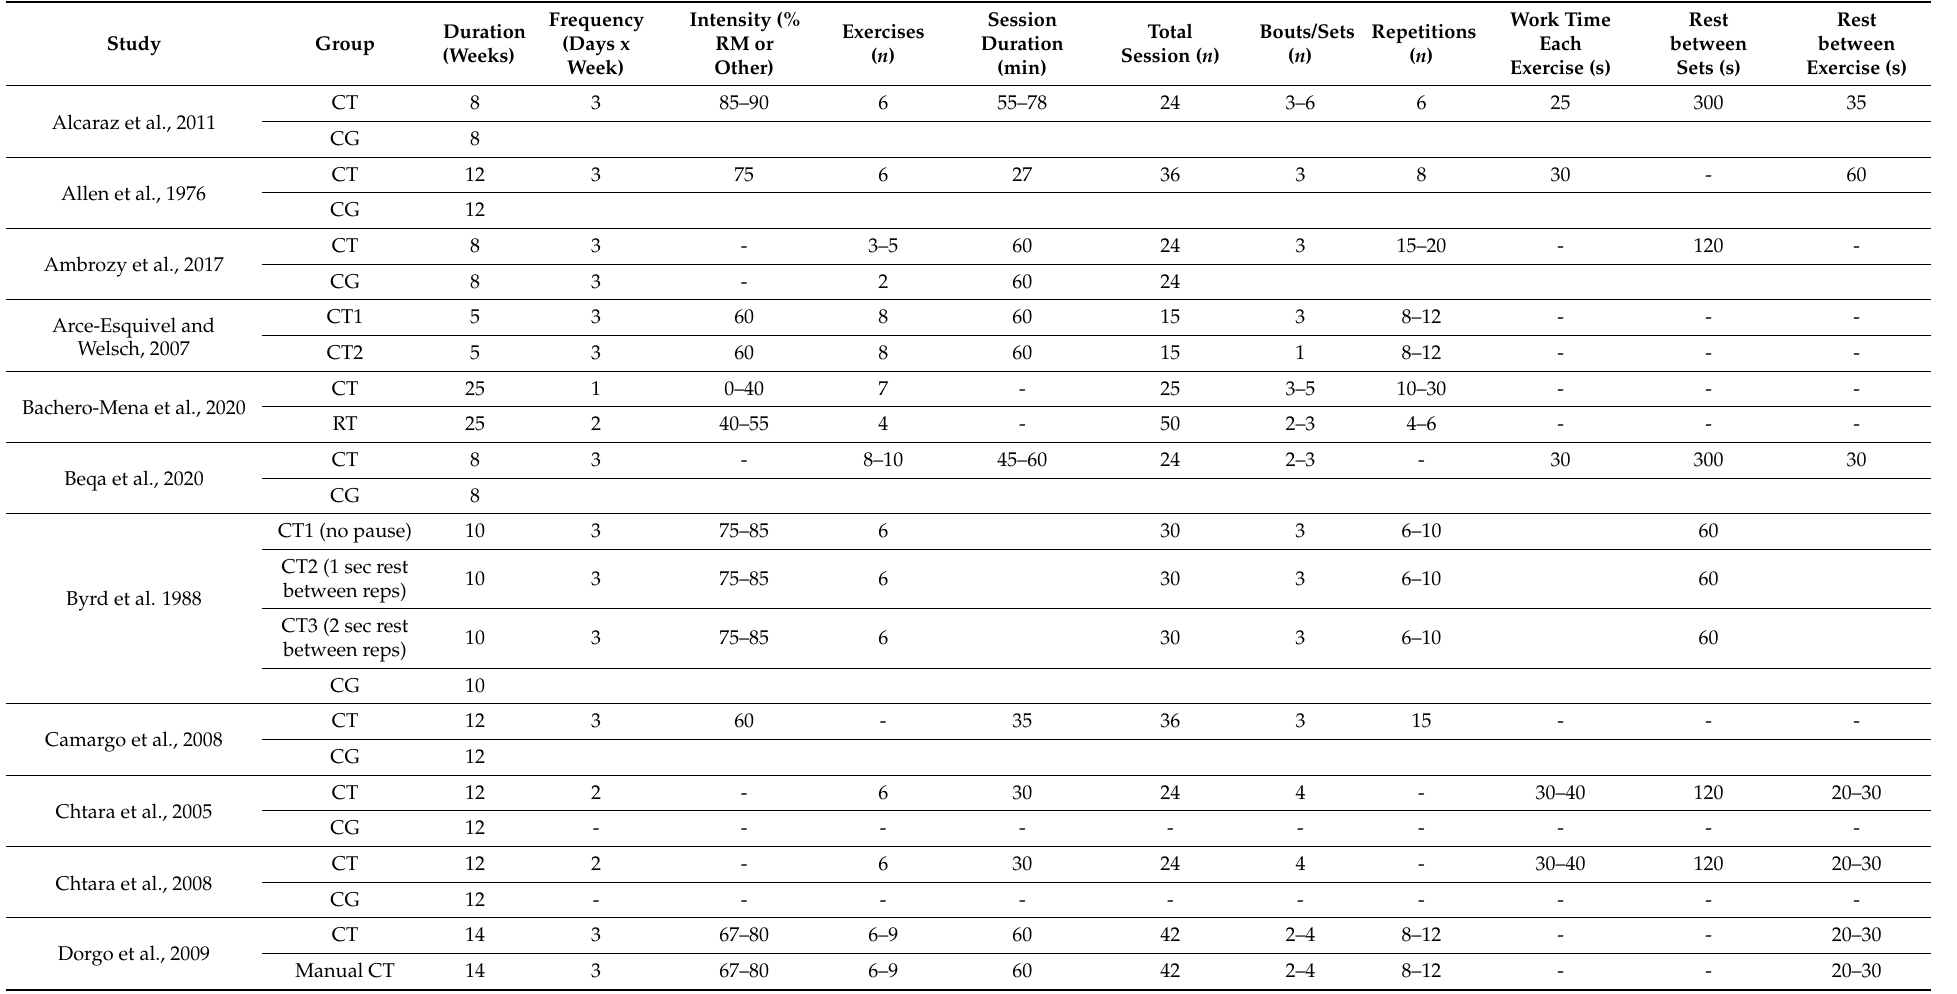
Table 1. Characteristics of the training intervention of studies included in the